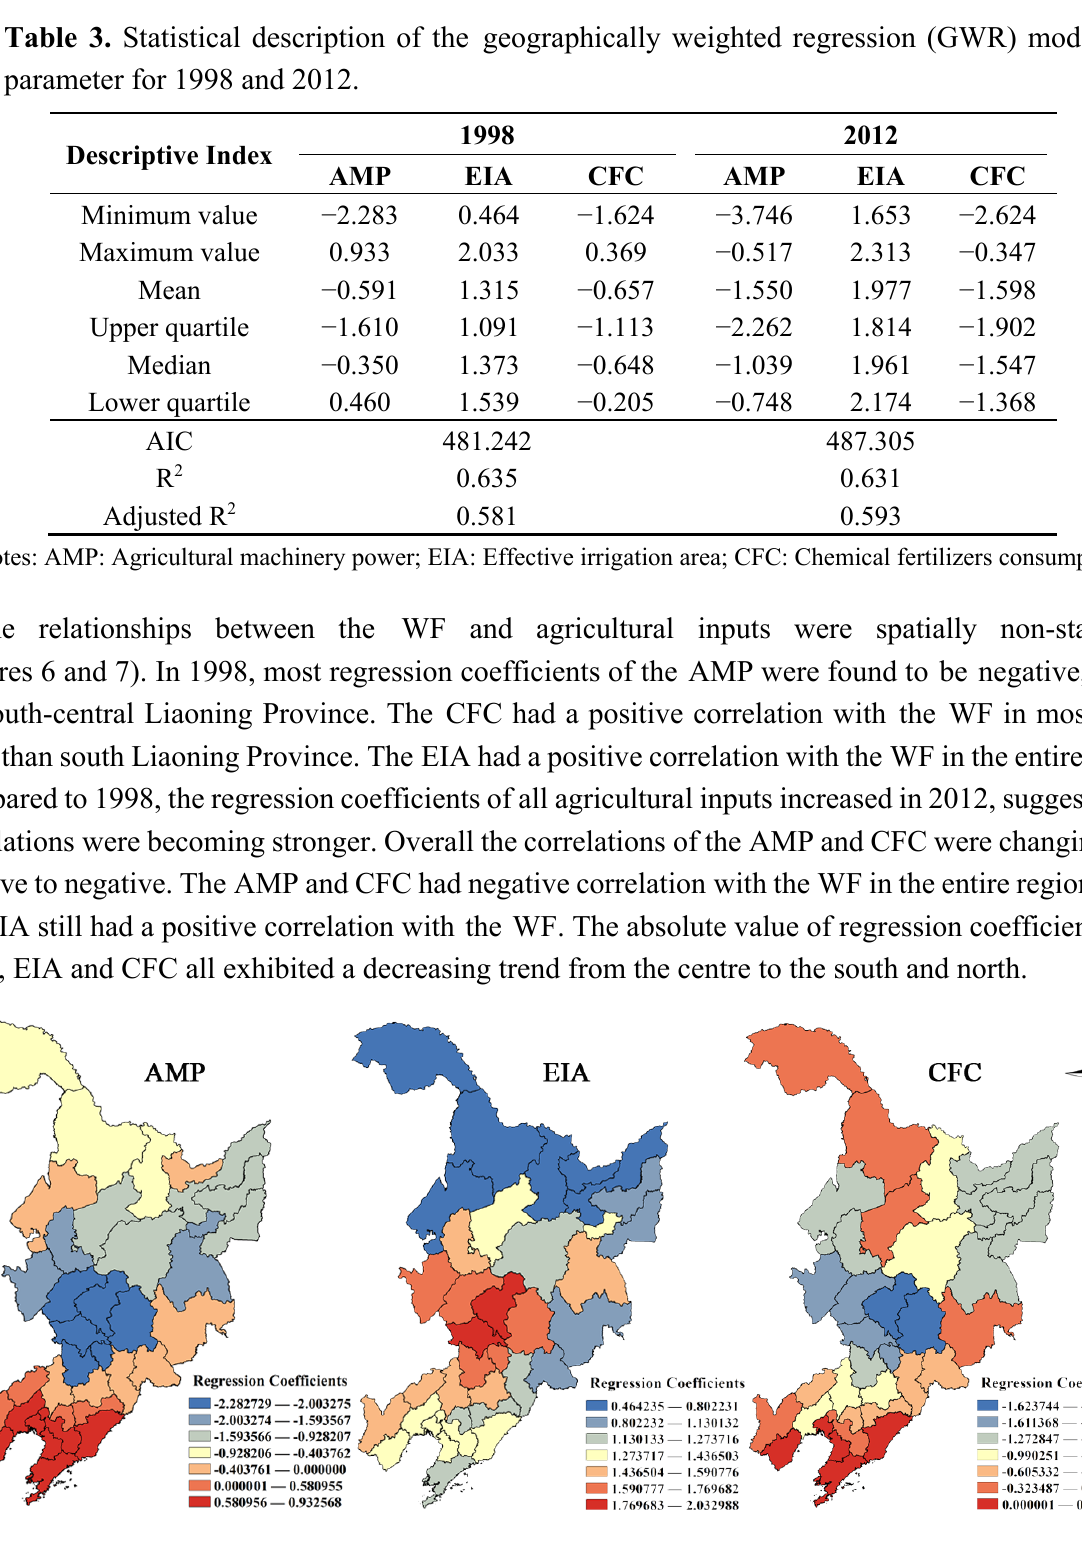
Figure 6. Spatial distribution of regression coefficients of agricultural inputs in